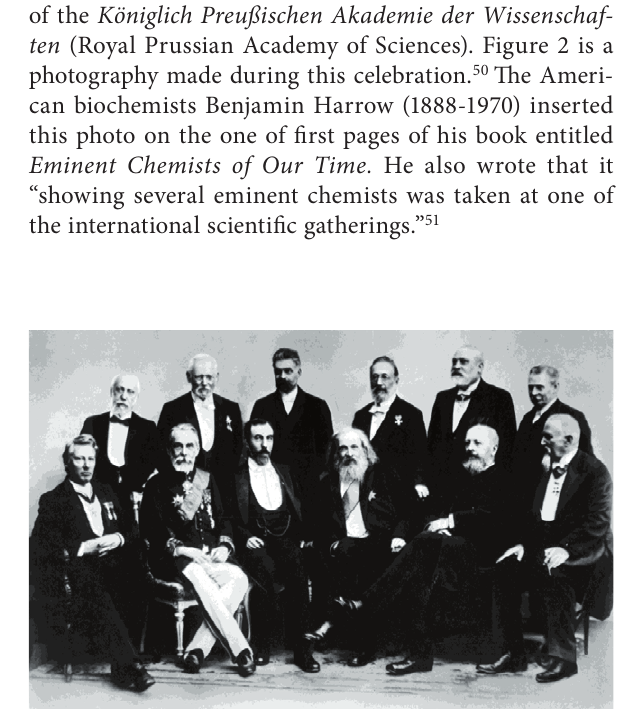
Figure 2. Ladenburg with the group of the prominent chemists (Public domain, from reference